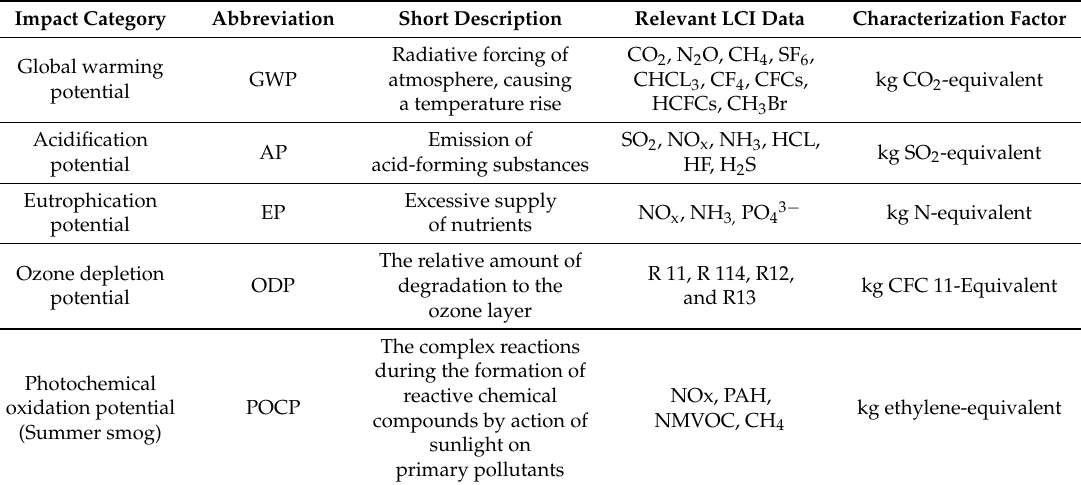
Table 2. TRACI impact categories considered in the